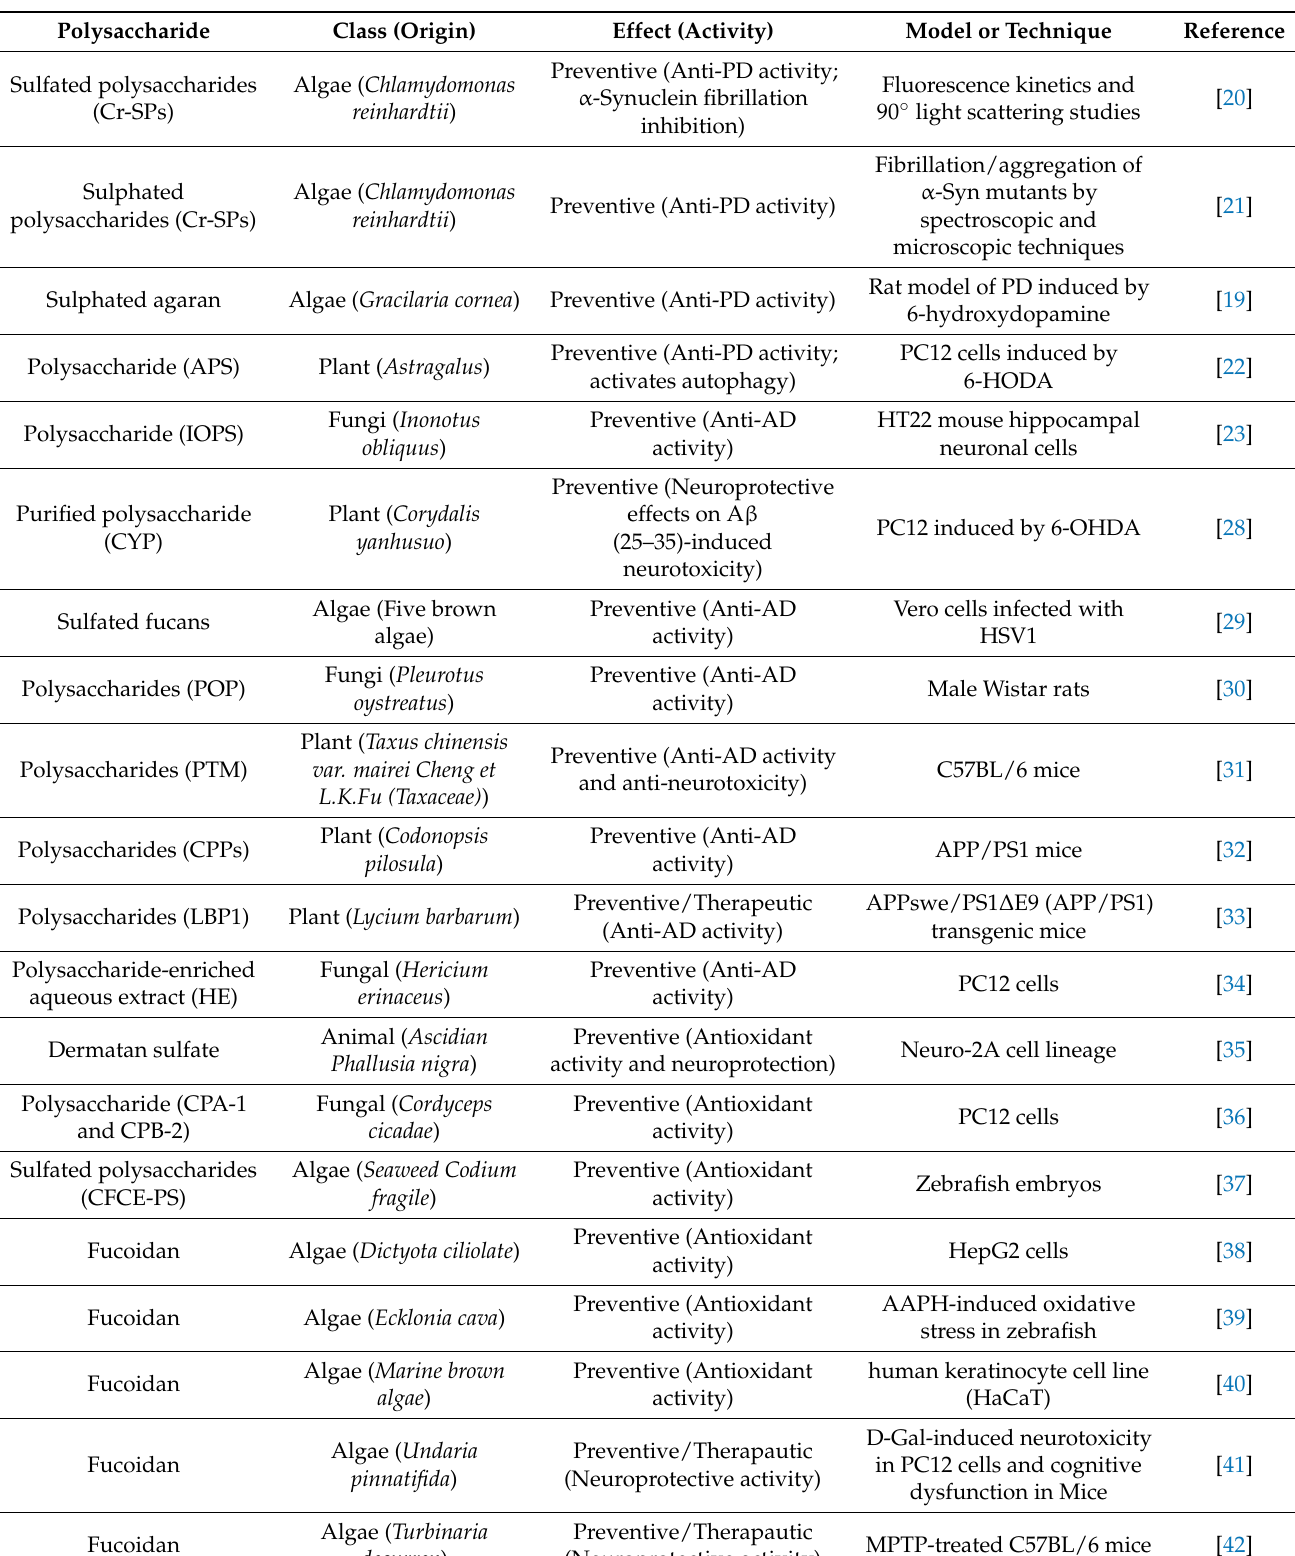
Table 1. Summary of neuroprotective and anti-neurodegenerative properties of natural polysaccha- rides described in scientific